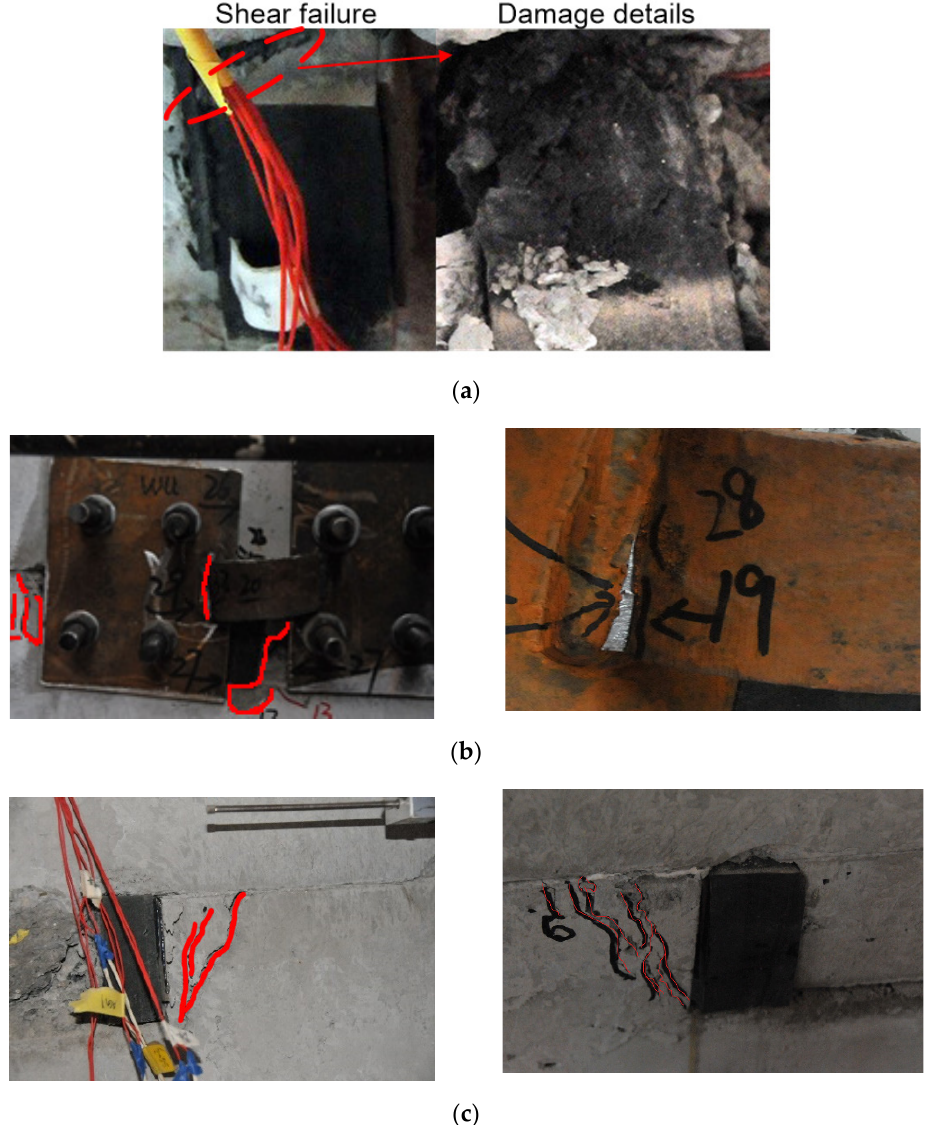
Figure 9. Failure phenomenon: ( a ) Oblique shear failure of the rubber blankets; ( b ) Failure program of the arc-shape energy absorption devices; ( c ) Concrete fracture of the specimens.